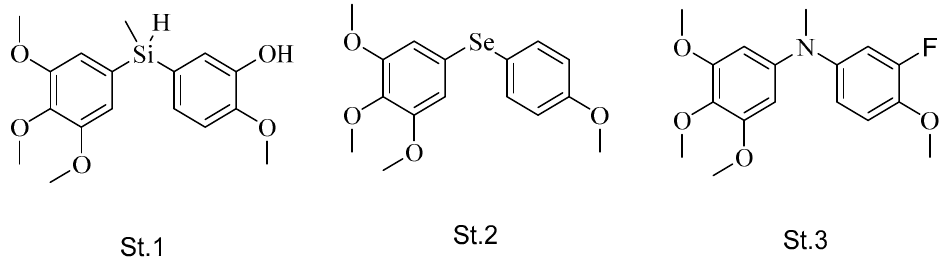
Figure 2. The structures of CA-4 analogues when the linker is replaced with hetero atoms (Si, Se, and N).